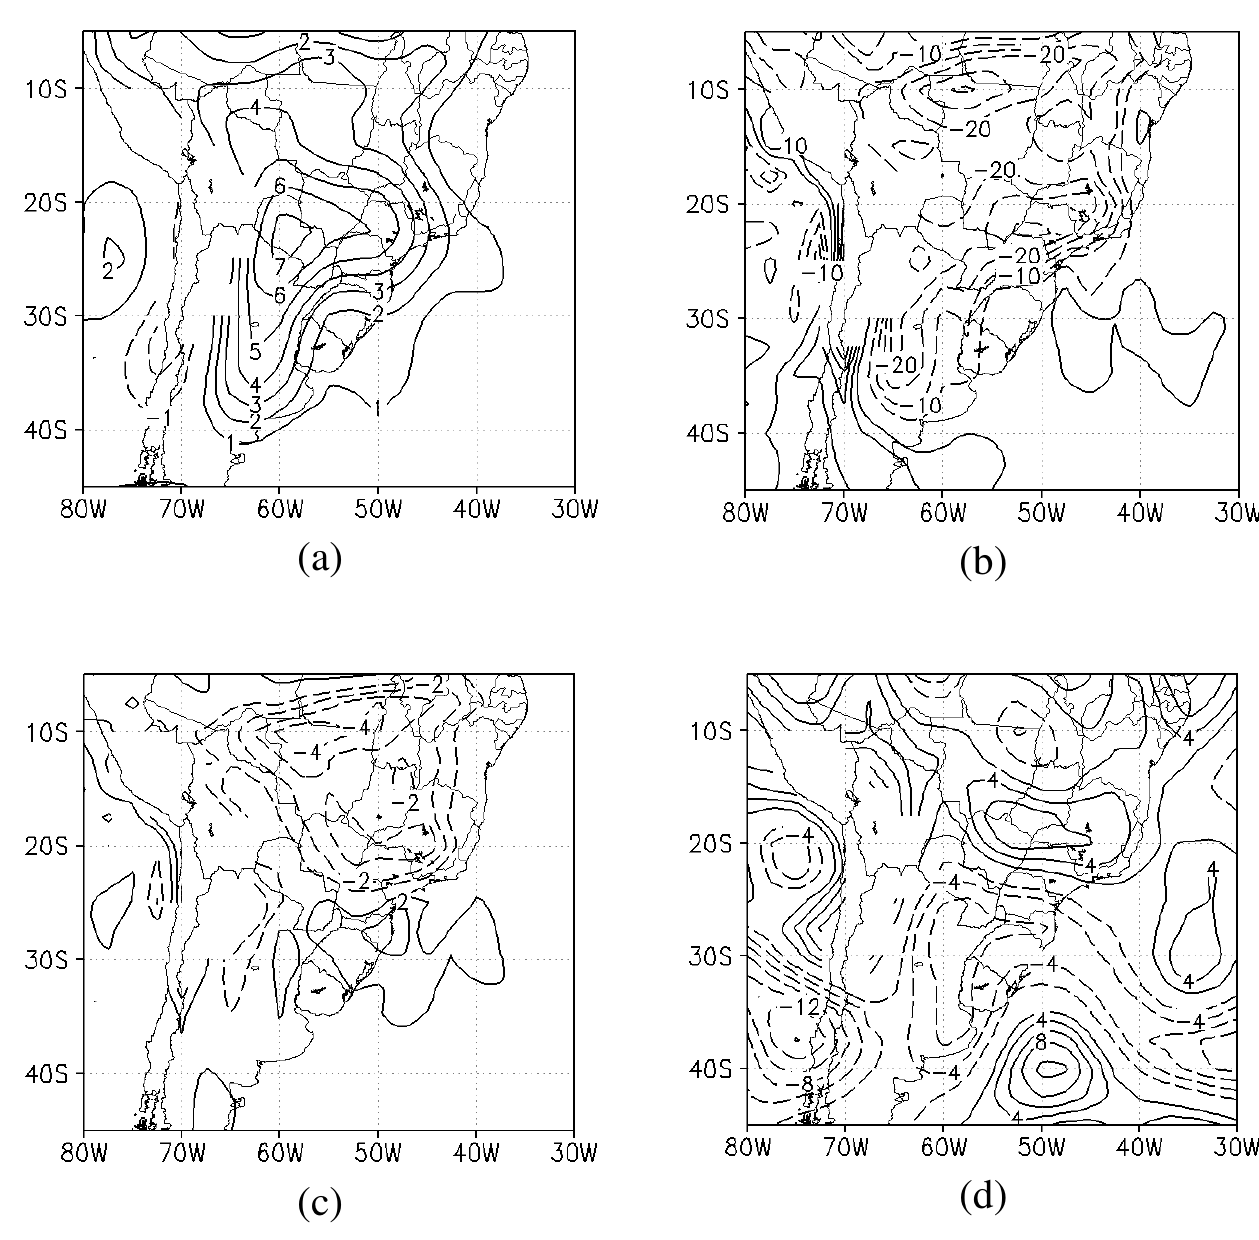
Fig. 7. Episode-mean anomaly fields for Case 29 (27 August through 10 September 1999) of (a) temperature ( ◦ C), (b) relative humidity (%), Fig. 7 – Episode-mean anomaly fields for Case 29 (27 Aug through 10 Sep 1999) of (a) and (c) specific humidity (gkg − 1 ) at 1000hPa (surface), and (d) vertical velocity (Pas − 1 ) at 500hPa, over South America at 00:00 UTC. Broken lines indicate negative temperature ( ° C), (b) relative humidity (%), and (c) specific humidity (g kg -1 ) at 1000 hPa (surface), and (d) vertical velocity (Pa s -1 ) at 500 hPa, over South America at 00 UTC. Broken lines indicate negative values.